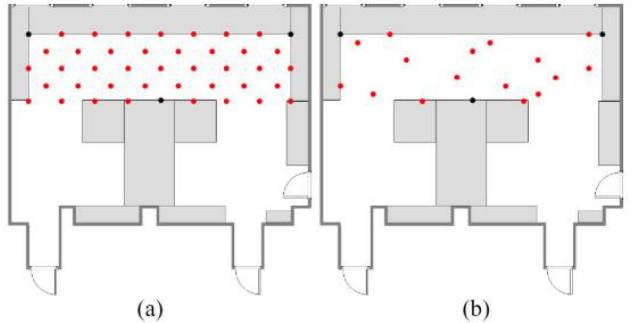
Figure 4. The environment of scenario 3. ( a ) Training data points. ( b ) Testing data points. The three black dots are AP locations, and the red dots are measuring points. Table 1. Sample records from the RSSI data set..